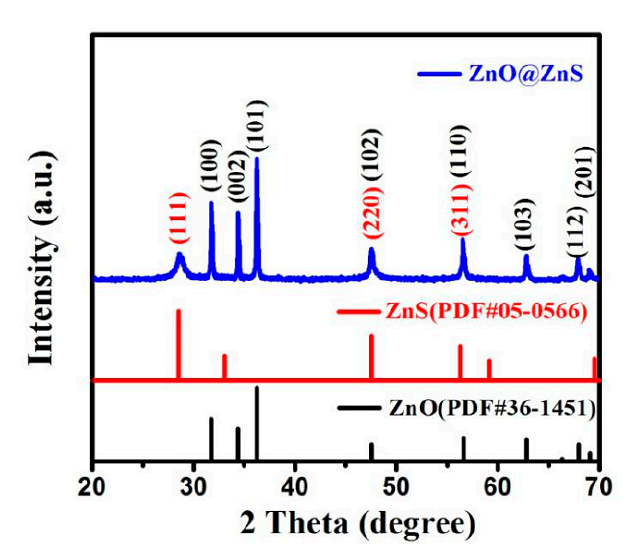
Figure 1. Powdered XRD patterns of the ZnO@ZnS